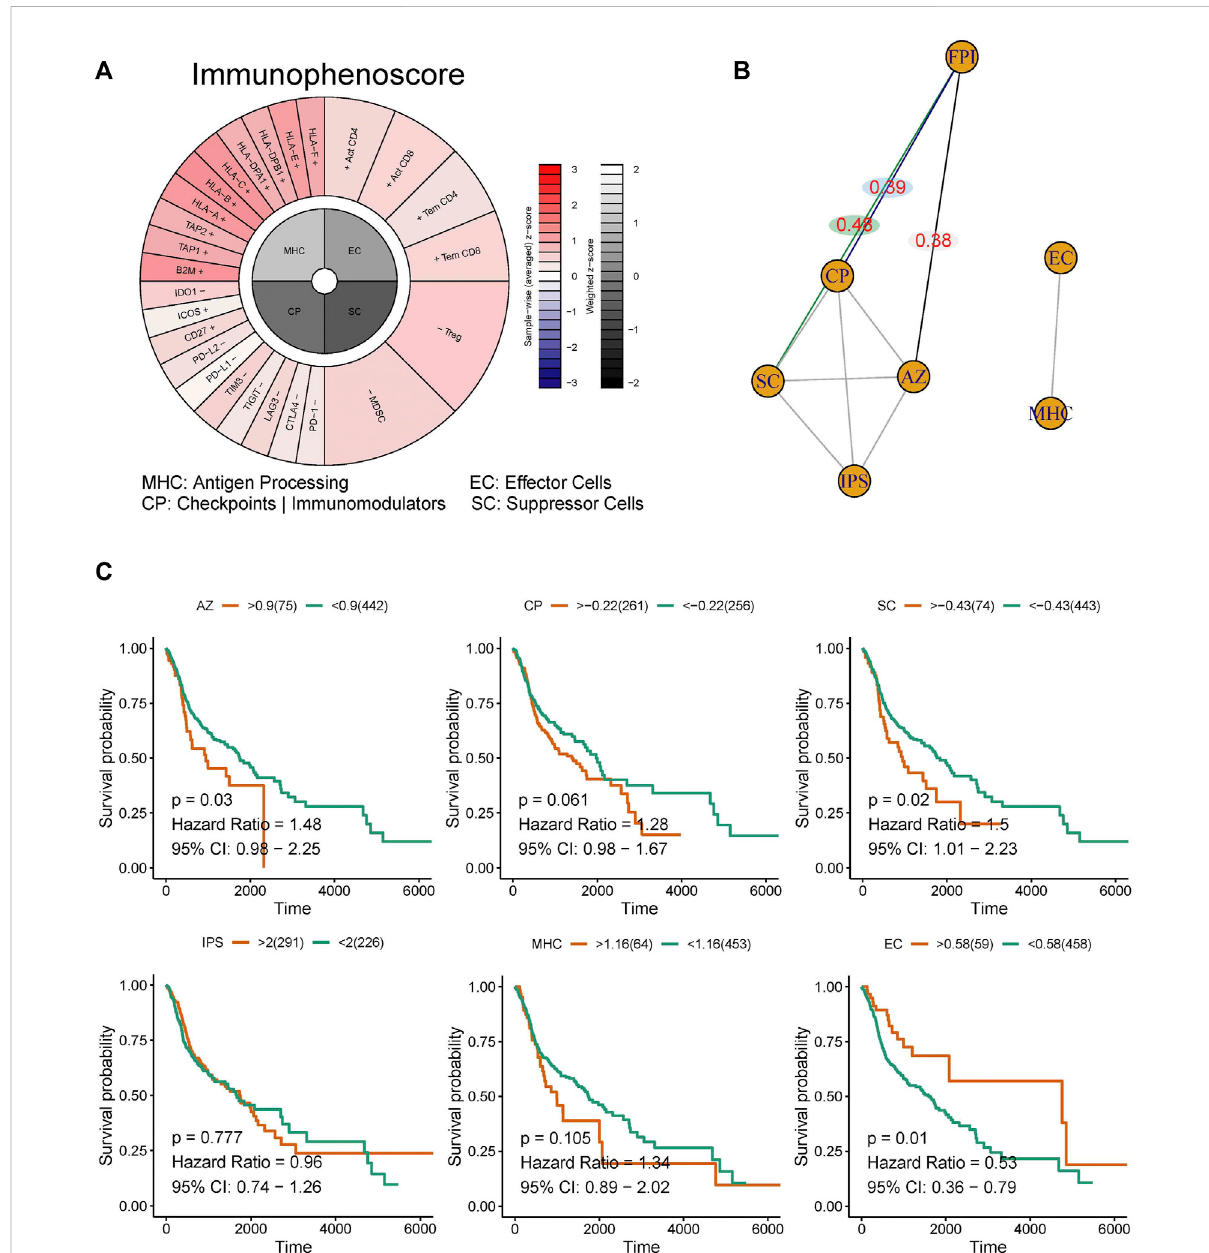
FIGURE 5 Correlation analysis among the ferroptosis pathway and immunotherapy response. (A) The immunophenotypes of tumor-immune landscape were calculated by Immunophenogram algorithm. Signi fi cant difference in FPI between HNSCC tumor tissues and normal tissues in TCGA. (B) The partialcorrelationsbasedonspearmananalysiswereidenti fi ed. (C) SurvivalanalysisshowedthatAZ,SC,andECweresigni fi cantlyassociatedwiththe OS of patients with HNSCC, but not with CP, MHC, and